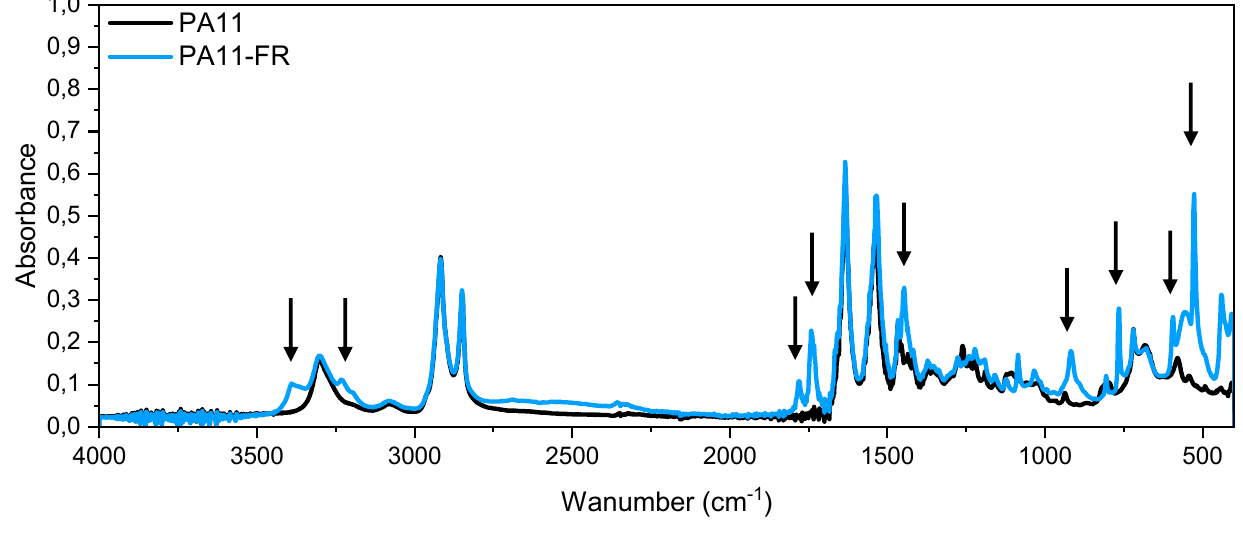
Figure 2. FT-IR spectra of PA11 and PA11-FR.